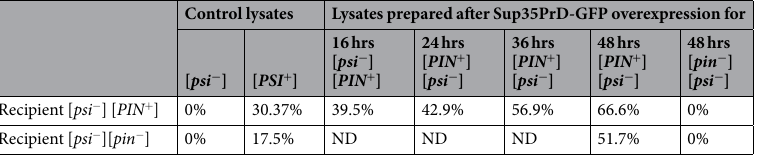
Table 1. Transfection of de novo formed Sup35PrD-GFP oligomers convert [ psi − ] into [ PSI + ]. Lysates from control strains ([ psi − ] or [ PSI + ]) or strains overexpressing Sup35PrD-GFP for indicated times were transfected into [ psi − ][ PIN + ] or [ psi − ][ pin − ] recipient cultures. Numbers indicate the percent of transfectants (approximately 200–300 transfectants scored) that were [ PSI + ]. ND = not determined. This table represents data from a single trial out of three independent trials. A binomial comparison test was performed between [ psi − ] and either [ PSI + ] or the induced cultures values, in order to determine the success of each pairing. All p-values obtained per pair in each of the three trials were less than 0.03. Simple linear regression indicated that transfection frequencies between 16, 24, and 48 hours were not different for all three